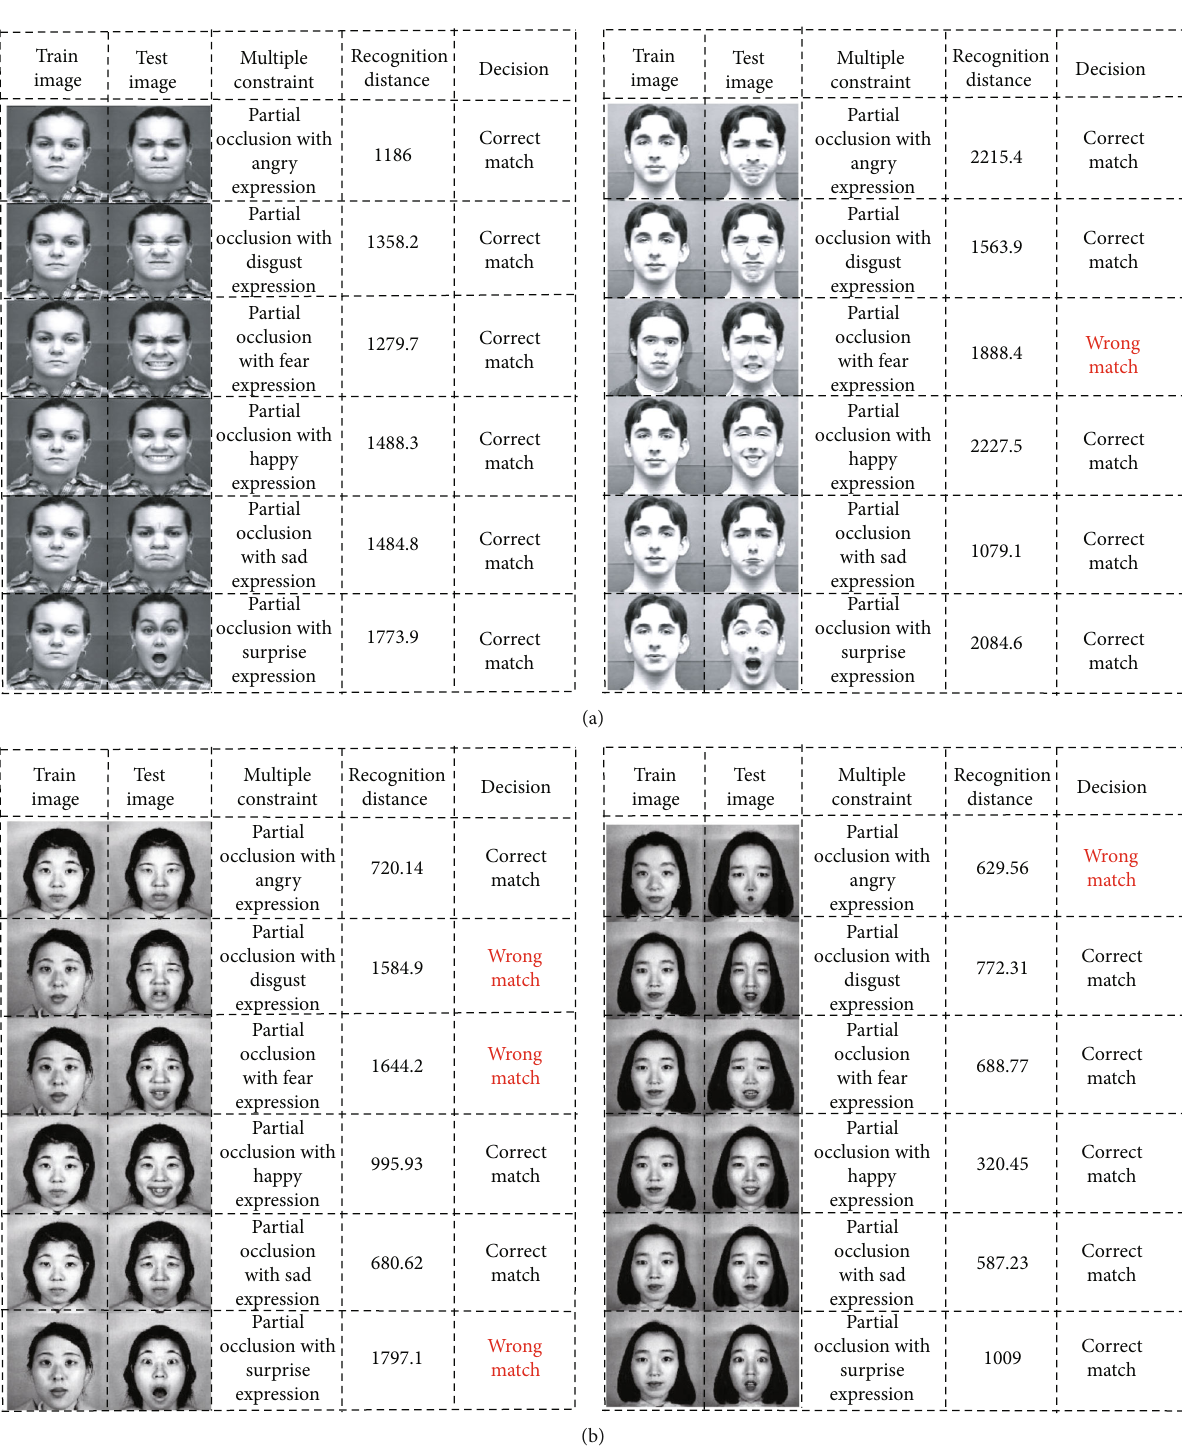
Figure 7: Recognition results of some left reconstructed face images with varying expressions: (a) sample recognition results from the CKFE database; (b) sample recognition results from the JAFFE From Table 1, the test statistic of the pairwise com- parison test is 17.20518 with a corresponding p value, p < 0 : 05 . This indicates that the null hypothesis of zero mean di ff erence is not tenable at 5 % level of signi fi cance.